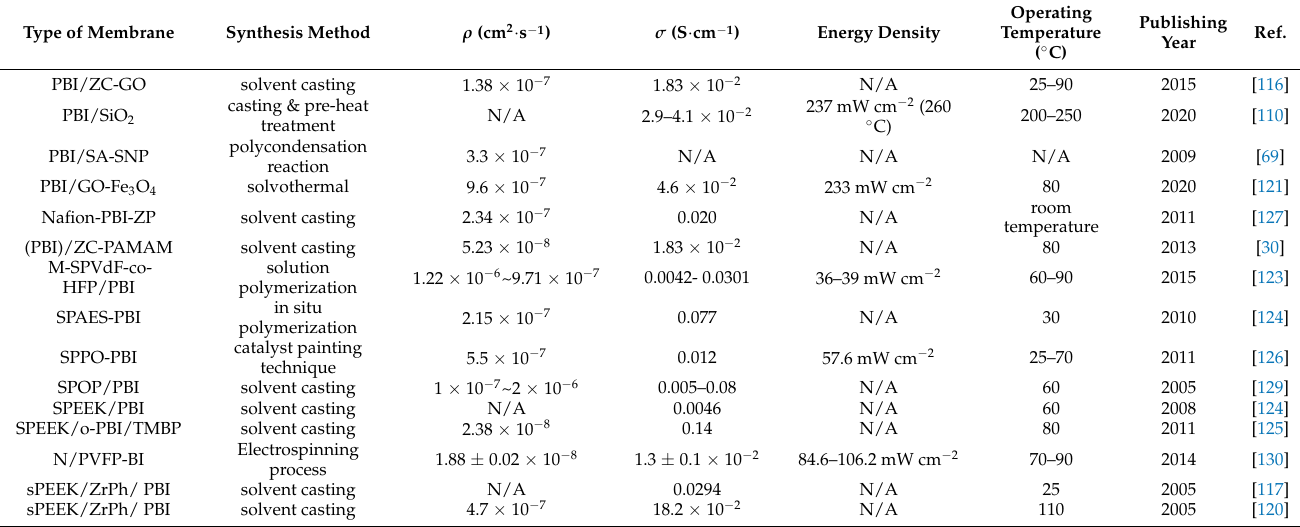
Table 5. The membrane properties of some representative studies on PBI PEMs in DMFCs (Acid components have been omitted in the column of “type of membrane” for phosphoric acid doped